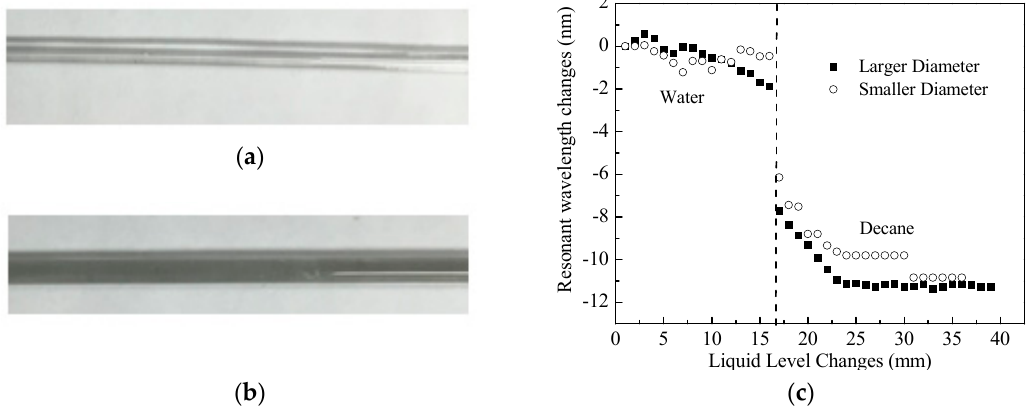
Figure 10. ( a ) Glass holding rod with outer diameter of 2 mm; ( b ) Glass holding rod with outer diameter of 3 mm; ( c ) Resonant wavelength changes of the LP 07 vs. layered liquid changes for two holding rods with two different sizes in layered liquids of water and decane.